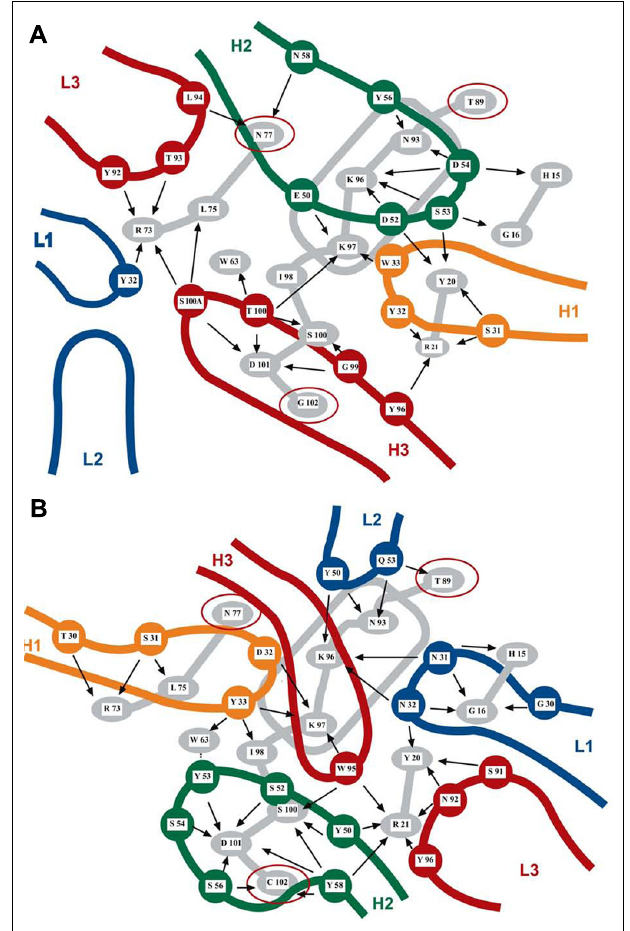
FIGURE 1 | Two overlapping discontinuous epitopes of lysozyme recognized by Mabs F9-13.7 (A) and HyHEL 10 (B) elucidated by X-ray crystallography.Thirteen residues of lysozyme (in gray) are recognized by both antibodies, albeit with different bonding patterns.The rounded rectangle in gray represents the lysozyme α -helix.The two sets of CDRs are shown in color and have different orientations on the lysozyme surface. Three residues (N77,T89, and G102 highlighted with red circles) are not shared by the two epitopes. Intermolecular contacts are shown by arrows. Mab HyHEL 10 forms a salt bridge between lysozyme K97 and residue D32 of the H1 antibody loop. Mab F9-13.7 forms salt bridges between lysozyme residues K97, K96, and H15 and respectively residues E50, D52, and D54 of the H2 antibody loop (adapted from Lescar etal., 1995, reproduced with